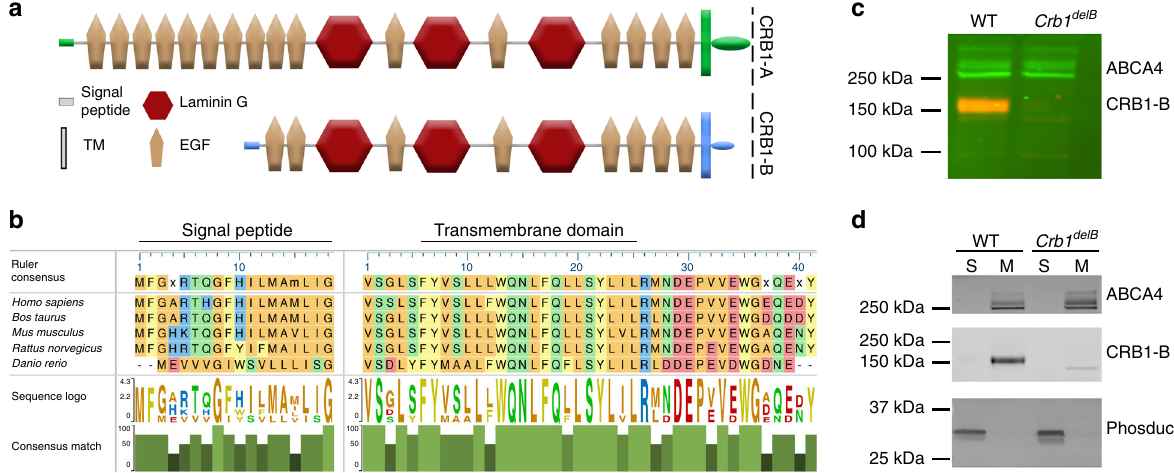
Fig. 7 Characterization of CRB1-B protein. a Domain structures of CRB1-A and CRB1-B protein isoforms. Green, A-speci fi c regions; blue, B-speci fi c regions. Each isoform has unique sequences at N-termini, predicted to encode signal peptides, and at C-termini, predicted to encode transmembrane (TM) and intracellular domains. b ClustalW alignment of unique CRB1-B sequences (blue in a ). Both N- and C-terminal regions are conserved across vertebrate species. c Western blot demonstrating CRB1-B protein expression in retinal lysates. CRB1-B antibodies were generated against unique CRB1-B C-terminus. Deletion of Crb1-B fi rst exon in mutant mice ( Crb1 delB allele; see Fig. 9a) demonstrates antibody speci fi city and also that the unique fi rst and last exons of Crb1-B are primarily used together, as predicted at transcript level (Fig. 5a). Photoreceptor protein ABCA4 is used as loading control. Also see Source Data fi le. d Western blot on retinal lysates separated into soluble (S) and membrane-associated (M) protein fractions. CRB1-B is detected in the membrane fraction. Loading controls: Membrane fraction, ABCA4; soluble fraction, Phosducin. Also see Source Data fi of CRB1-B in the photoreceptor layer, predominantly within the inner and outer segments. This localization is in marked contrast to CRB1-A which has been localized to the apical tips of Müller cells, within the OLM (Fig. 8a), using antibodies speci fi c to this isoform 37,51 .